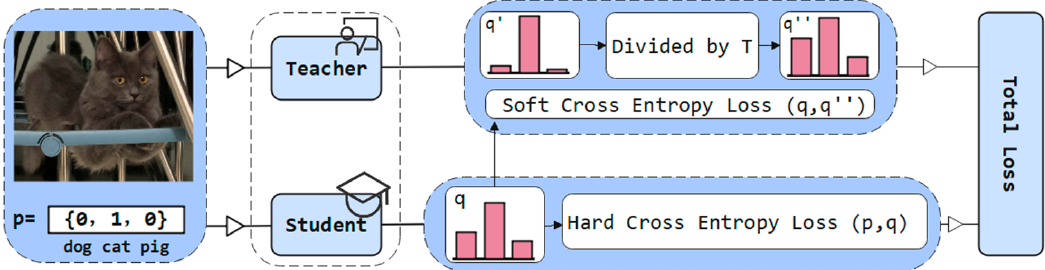
Figure 3. The main idea of knowledge distillation. The label of the input image is cat; the probability is expressed as {0, 1, 0}. After the inference of teacher network and student network, the algorithm outputs classification results q and q’, so that the image is declared as a cat. However, this image also shows some dog traits, which is not shown obviously in q and q’. After softening the teacher network, the dark knowledge appears. The classification result is q”, which provides more dark knowledge. Training the student network with the teacher network makes the student network more accurate on the basis of the teacher network’s characteristics.